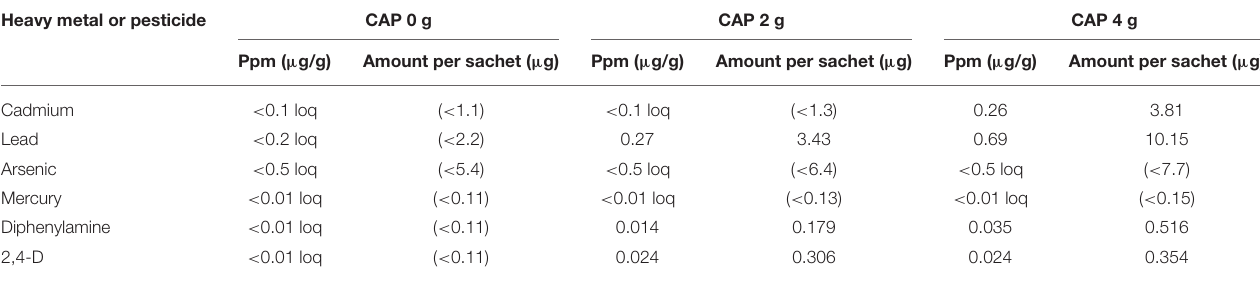
TABLE 3 | Heavy metal and pesticide residue content in CAP 0, 2, and 4g.